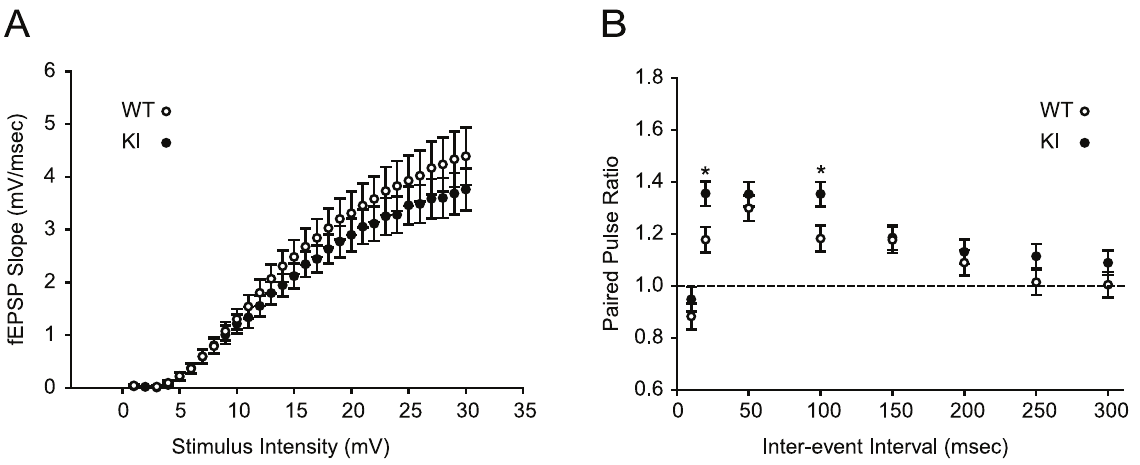
Figure 1. Enhanced PPRs in Dyt1 D GAG heterozygous KI mice. (A) The input-output curves in Dyt1 D GAG heterozygous KI mice were unaffected. (B) Dyt1 D GAG heterozygous KI mice showed significantly enhanced PPRs at two inter-stimulus intervals (20 and 100 msec). Circles represent means 6 standard errors. Open circles denote data from WT. Filled circles were from Dyt1 D GAG heterozygous KI mice. * p , 0.05. doi:10.1371/journal.pone.0072491.g001 (Fig. 3C; WT, 12.0 6 0.4; KI, 12.5 6 0.4; p . 0.05), and rise (Fig.